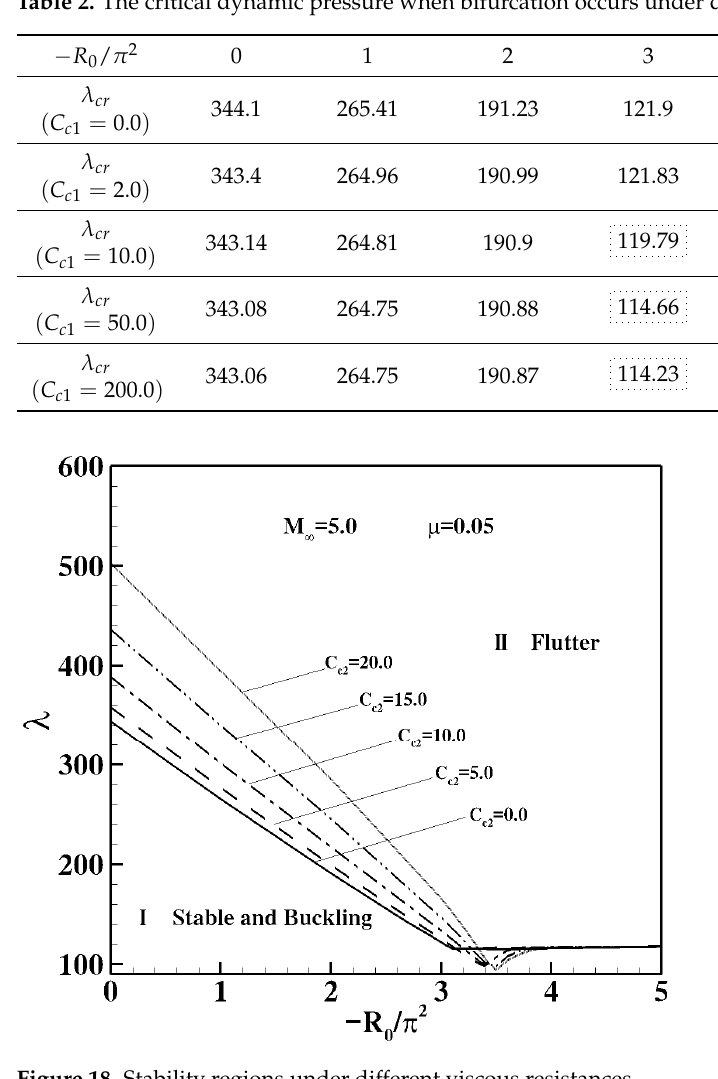
15 of 22 Figure 17. Peak of deformation versus dynamic pressure under different inertial and viscous re- sistances: ( a ) inertial resistances; ( b ) viscous resistances Table 2 shows the critical dynamic pressure of the panel under an in-plane load at different inertial resistances. As the in-plane load increases, the critical dynamic pressure first decreases and then tends to be stable. When 2 0 / 0, 1, 2 R π− = , the critical dy-